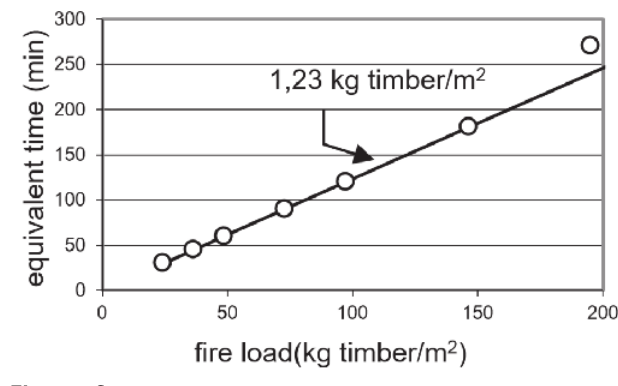
Time equivalent by the concept of the equality of areas under the curves as Ingberg